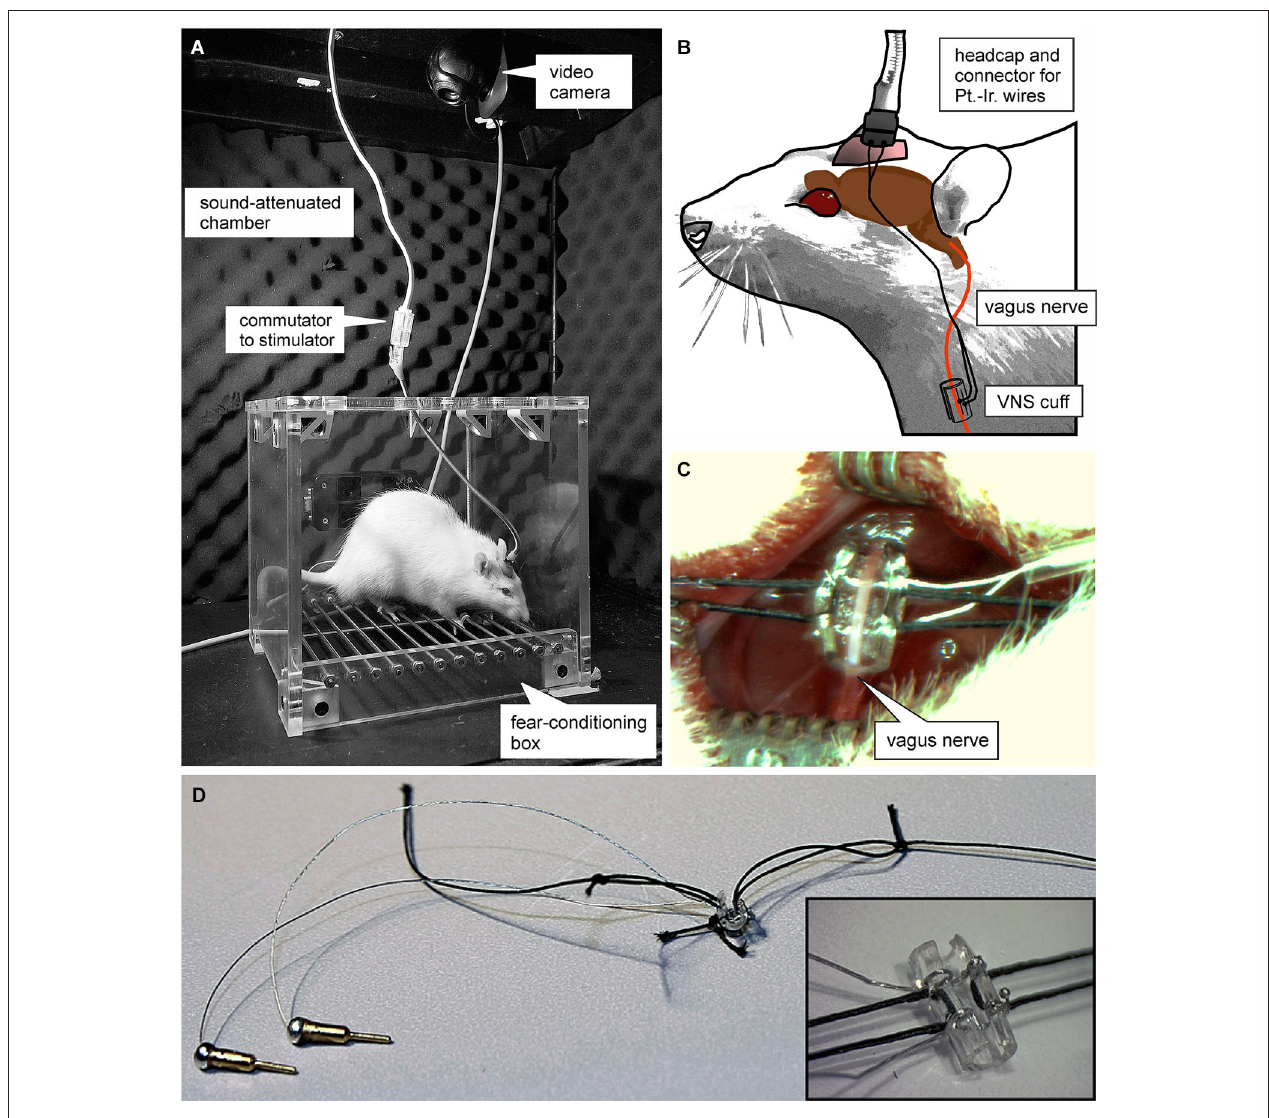
to a custom-made “cuff-electrode” that is wrapped around the vagus nerve. ( C and D ) Photomicrographs of the cuff electrode used for VNS. (C) shows the surgical incision and the exposed vagus nerve before the cuff electrode is sutured around